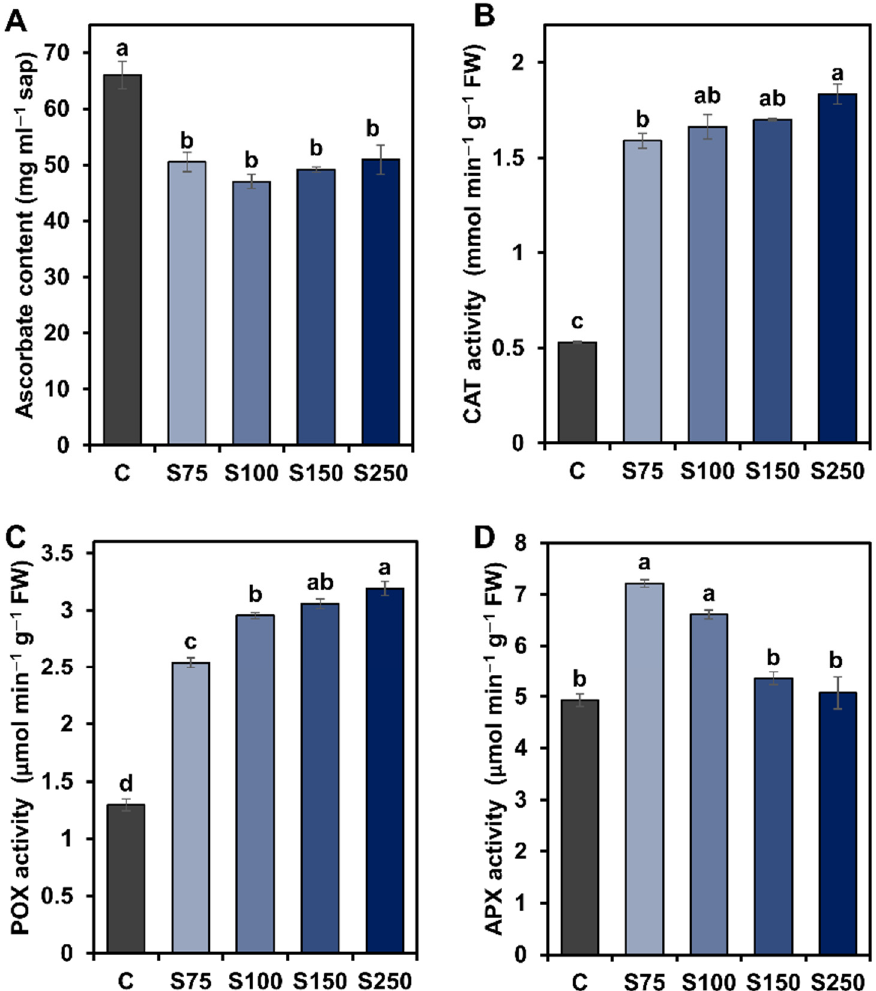
Figure 4. E ff ects of soil salinity on ascorbate content ( A ), catalase (CAT) activity ( B ), peroxidase (POX) activity ( C ) and ascorbate peroxidase (APX) activity ( D ) in sugar beet after exposure to various salt concentrations for 95 days. Each bar represents the average of three independent replicates ( n = 3), and the error bar denotes standard errors. Statistically significant di ff erences among di ff erent treatments are designated by di ff erent alphabetic letters based on Tukey’s honestly significant di ff erences test ( p < 0.05). Control (C), 0 mM NaCl; S75, 75 mM NaCl; S100, 100 mM NaCl; S150, 150 mM NaCl; S250, 250 mM NaCl.